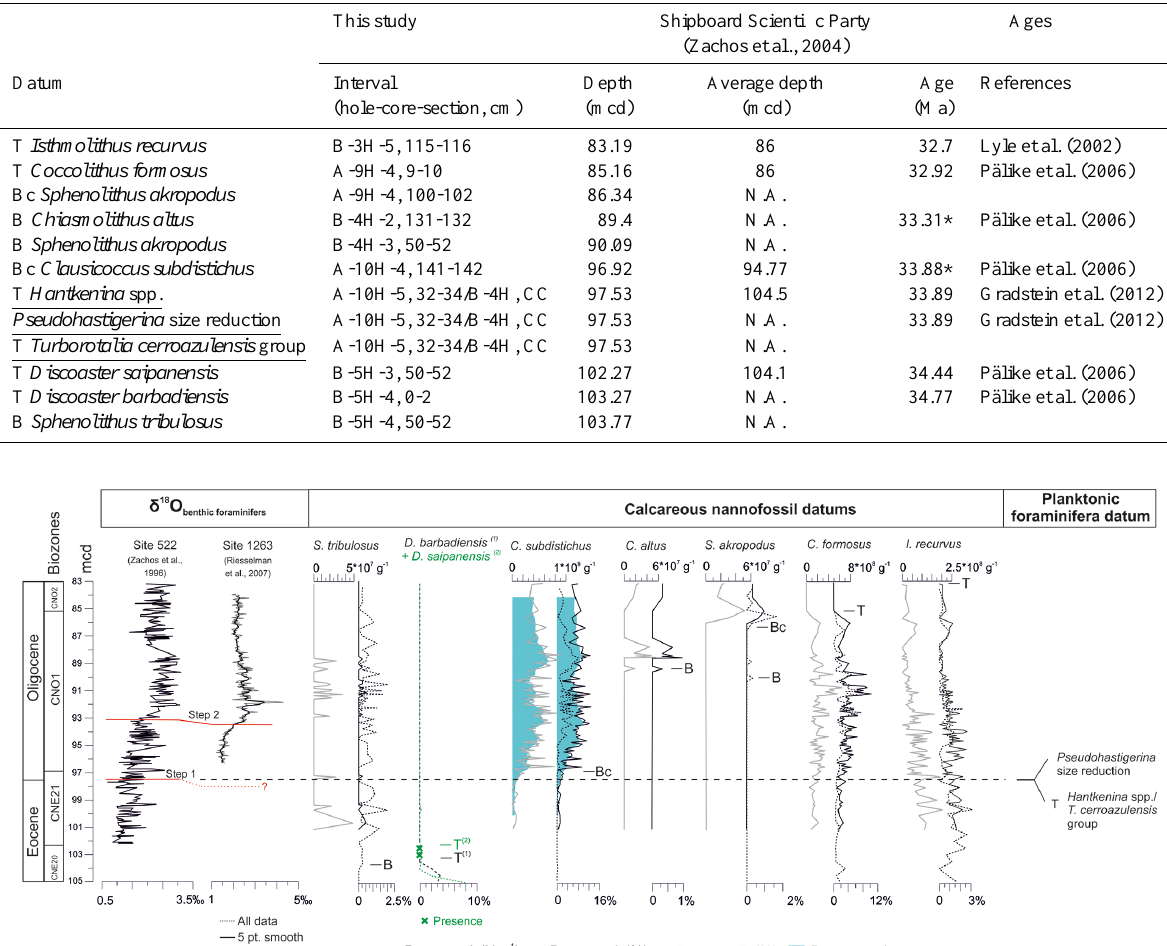
Table 1. Calcareous nannofossil and planktonic foraminiferal (underlined) bioevents as identified in this study (at meter composite depth, mcd) and themcd reported by the Shipboard Scientific Party (Zachos et al., 2004). Note that for the planktonic foraminiferal bioevents the average depth is reported. For each bioevent, the ages available in the most recent literature are given. N.A.: datum not available; *: ages not included in the sedimentation rate estimate.